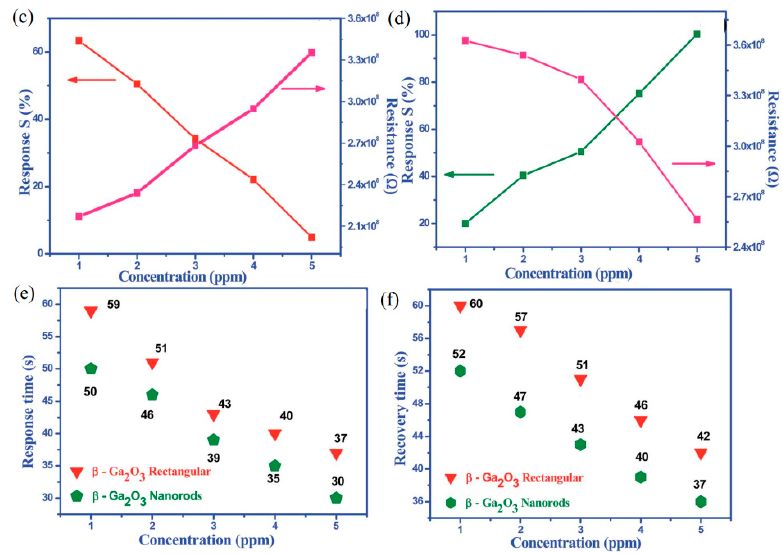
Figure 11. Nitrogen adsorption-desorption isotherm of the Ga 2 O 3 ( a ) rectangular and ( b ) rod-shaped nanostructures (inset: the corresponding pore size distribution). Sensing response and electrical resistance as a function of CO concentration at 100 ◦ C ( c ) β -Ga 2 O 3 rectangular nanorods, ( d ) β -Ga 2 O 3 nanorods, ( e ) response time, and ( f ) recovery time of different β -Ga 2 O 3 nanostructure thin films [135]. Copyright 2016 The Royal Society of Chemistry.